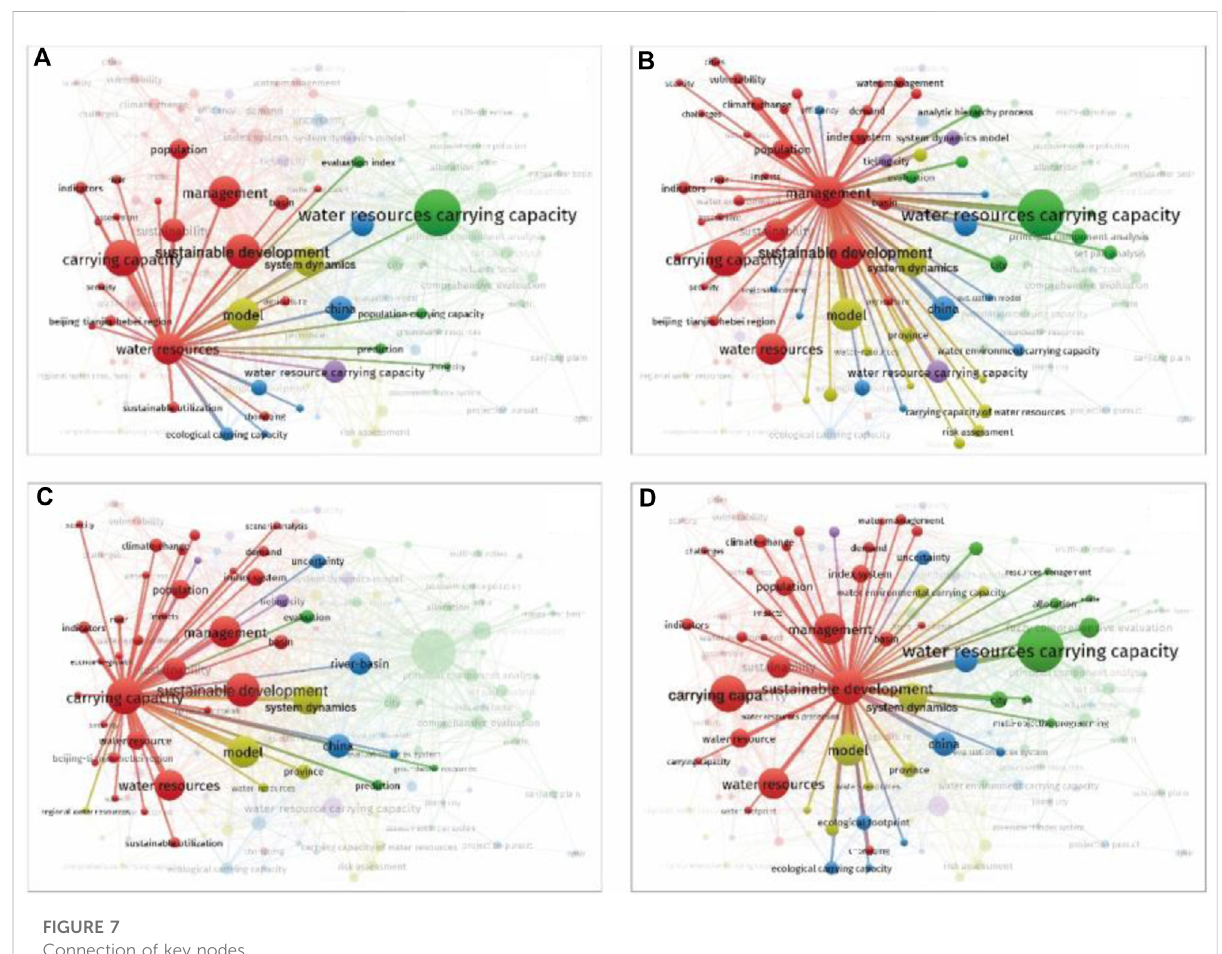
FIGURE 7 Connection of key